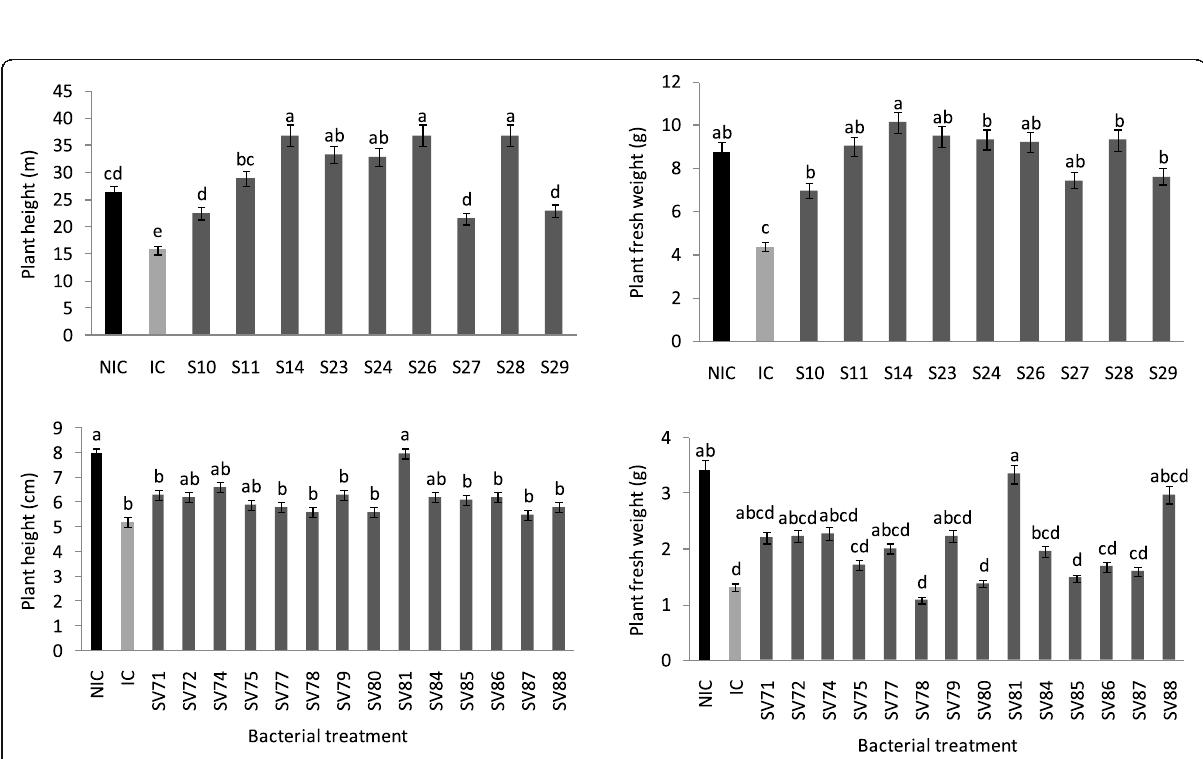
Fig. 2 Effect of endophytic bacteria recovered from Solanum sodomaeum and Solanum bonariense on growth promotion of tomato cv. Rio Grande plants inoculated with Fusarium oxysporum f. sp. lycopersici compared to the untreated controls. S11, S14, S26, S27, S28, and S29 are bacterial isolates recovered from S . sodomaeum . S23, S24, SV71, SV72, SV74, SV75, SV77, SV78, SV79, SV80, SV81, SV84, SV85, SV86, SV87, and SV88 are bacterial isolates recovered from S . bonariense . NIC, un-inoculated with pathogen and untreated control. Bars sharing the same letter are not significantly different according to Student-Newman-Keuls test at P ≤ 0.05